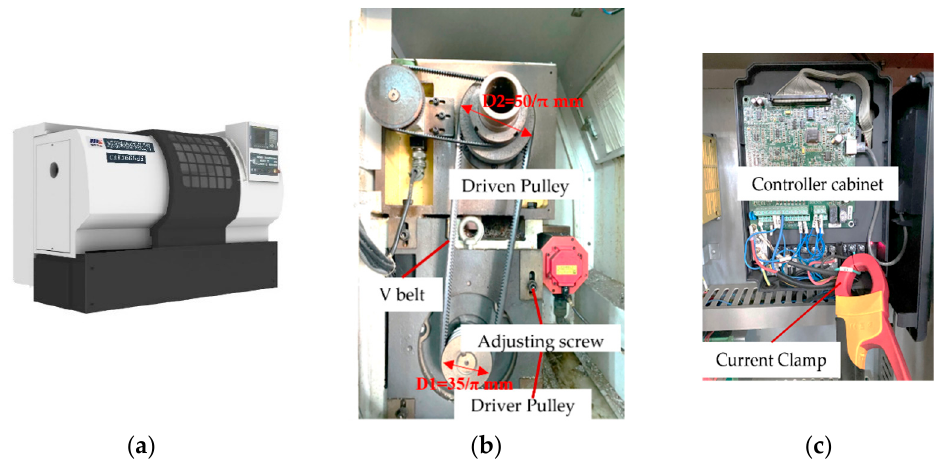
Figure 15. Experimental facilities: ( a ) CNC lathe, ( b ) belt transmission system, and ( c ) current clamp